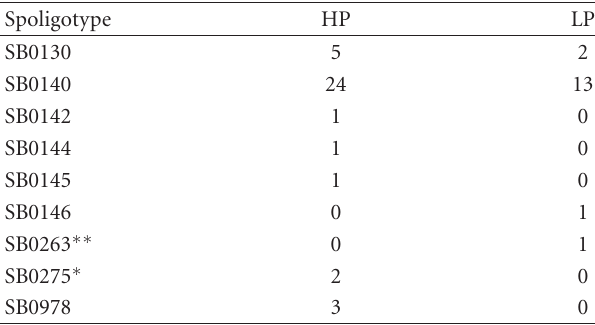
Table 1: Number of badgers infected with each M. bovis spolig-